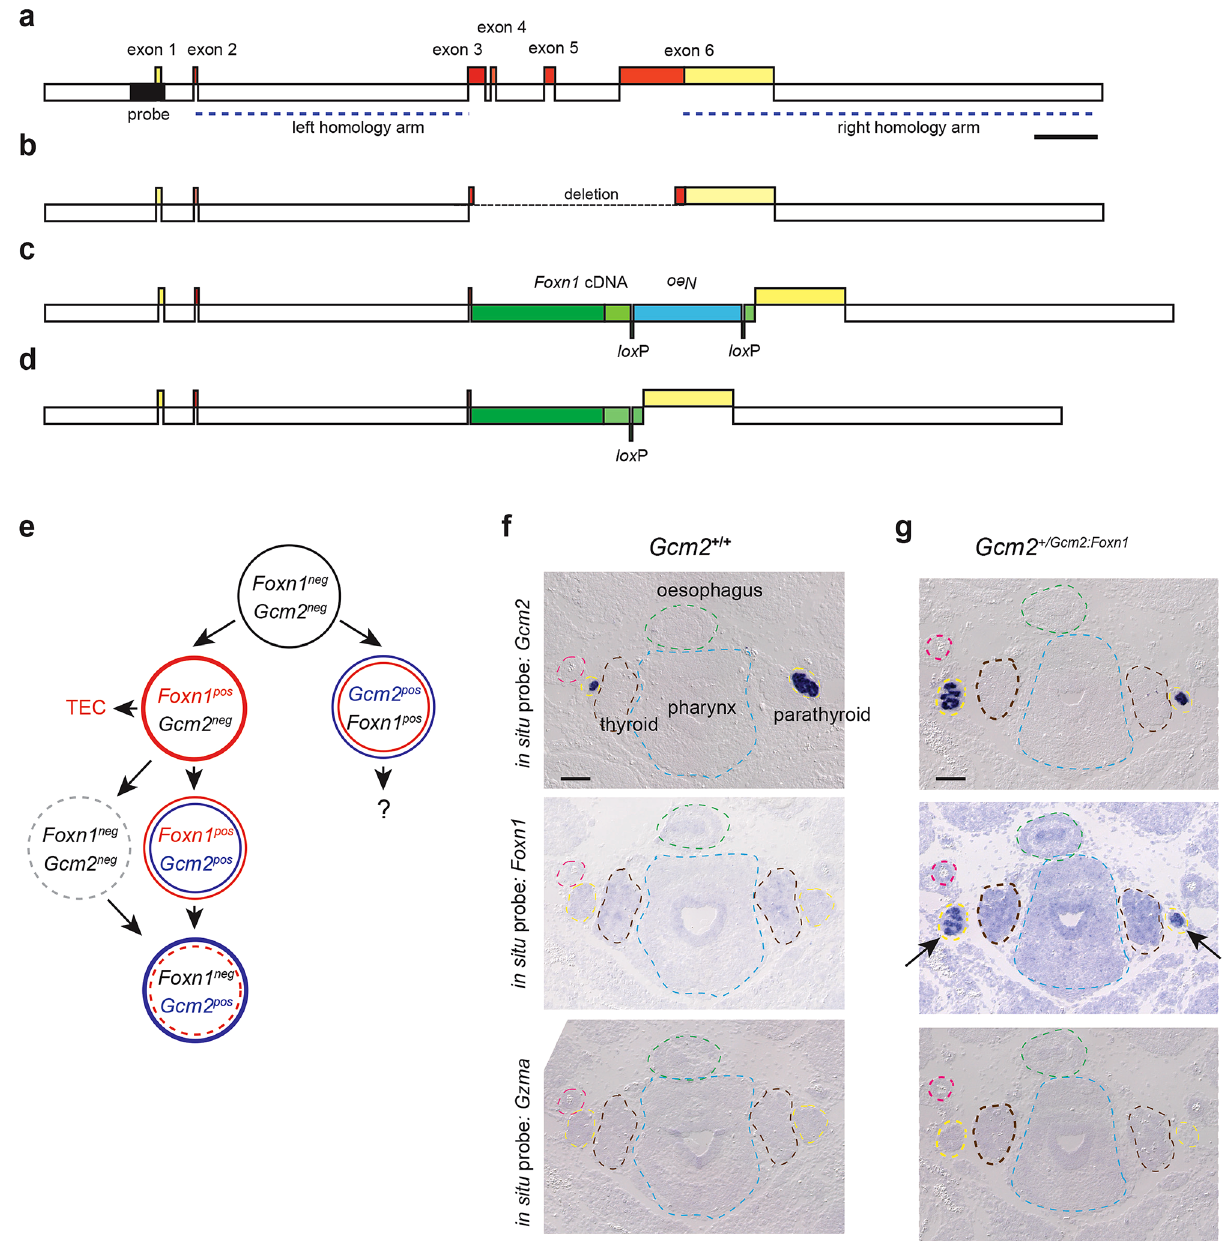
Figure 4. Ectopic expression of Foxn1 in the parathyroid. ( a–d ) Structure of Gcm2 alleles generated in this study. ( a ) Structure of the wild-type Gcm2 locus on mouse chromosome 13. Exons are depicted as red boxes, the 5´- and 3´-untranslated regions are shown in yellow. The initiation codon occurs in exon 2, the stop codon is situated in exon 6. The sequence contained in the fragment used for Southern blot hybridisation is indicated in black and lies outside of the homology arms that were contained in the replacement fragment. The sequences represented in the construct used for homologous recombination are indicated as blue dashed lines. ( b ) Structure of the Gcm2 null allele. The deleted region extends from exon 3 into exon 6 and is indicated by a dashed line. ( c ) Structure of Gcm2 locus after homologous recombination. The deleted region is replaced by a cassette consisting of the mouse Foxn1 cDNA (coding region depicted in dark green; the 3´-untranslated region in light green), and a Neo gene (blue), which is positioned in opposite transcriptional orientation; the latter is flanked by two lox P sites in tandem orientation (green boxes). ( d ) Structure of Gcm2 locus after homologous recombination and removal of the Neo cassette, which leaves one lox P site behind. ( e ) Developmental trajectories under conditions of ectopic Foxn1 expression in the parathyroid; note that the development of the mediastinal and cervical thymi and the hypothetical thymus-fated parathyroid are expected to occur normally. ( f ) RNA in situ hybridisation of adjacent E14.5 tissue sections of the pharynx of wild-type mice with probes specific for Gcm2 , Foxn1 , and Gzma . The organ primordia and other anatomical features are outlined by coloured dotted lines. Note that the size of the parathyroid is variable in individual sections. For orientation, the common carotid artery is indicated by red circle on one side of the section. Tissue sections representative of ten mice. ( g ) Hybridisation of sections equivalent to those in ( f ) from mice heterozygous for the Gcm2:Foxn1 knock-in allele. The Foxn1 -expressing parathyroid glands are indicated by arrows. Tissue sections representative of 2 mice. Scale bars, 0.1